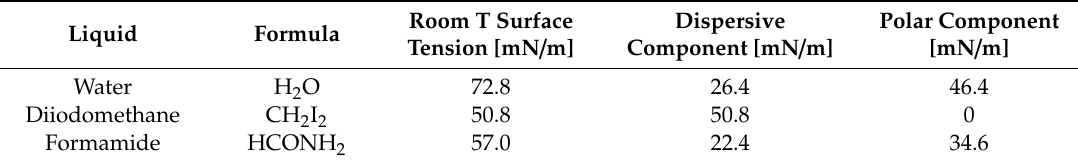
Table 2. Surface tension components of the reference liquids